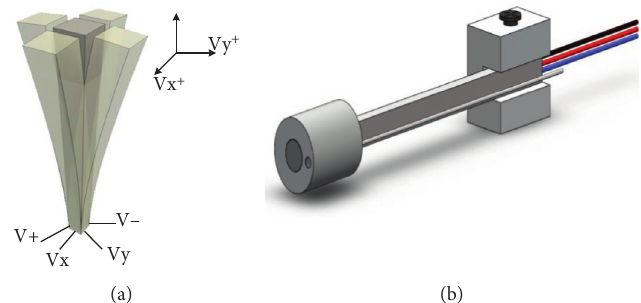
Figure 3: (a) Schematic diagram of a 2D piezoelectric ceramic displacement. (b) Piezoelectric ceramic and optical fiber connection structure.